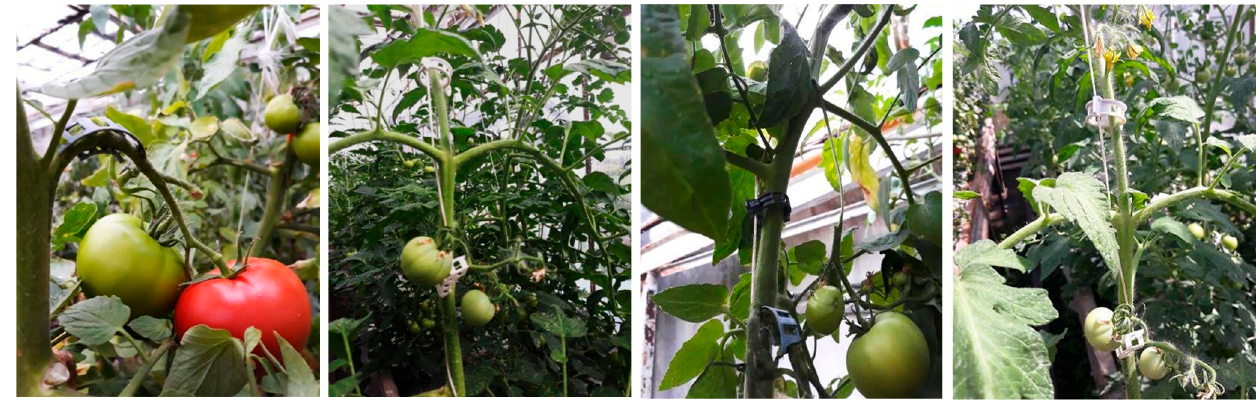
Figure 5. Stem and arch support clips (CUT 1 and CUT 2) applied to tomatoes in a greenhouse trial.